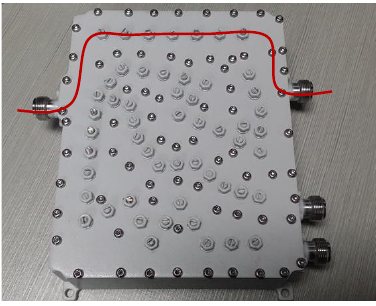
Figure 7. The combiner with four channels to be tuned in the experiment. The red spline denotes the channel used for